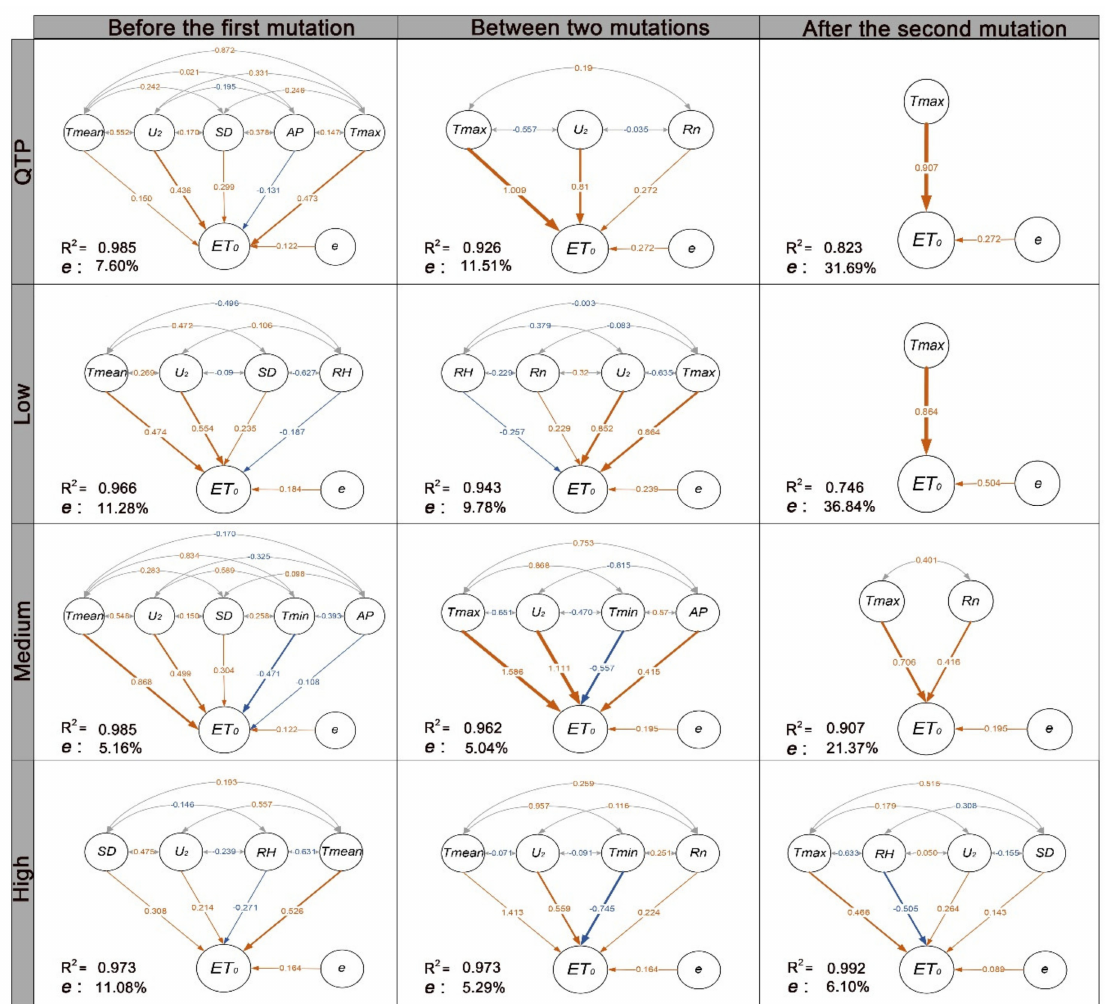
Figure 7. The distribution of the statistical Z-value from the MK test of four seasons at each station of QTP from 1961 to 2017. At α = 0.05 significance level, if | Z | > 1.96, the ET 0 changes significantly. At α = 0.001 significance level, if | Z | > 3.25, the ET 0 change is extremely significant. The red bubble represents the increasing trend, the blue represents the decreasing trend, and the larger the bubble is, the more significant the change trend